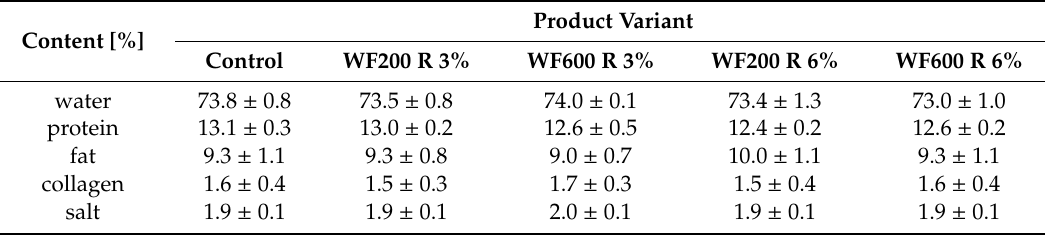
Table 1. Basic chemical composition of the model homogenized sterilized canned meat products (mean ± standard deviation)